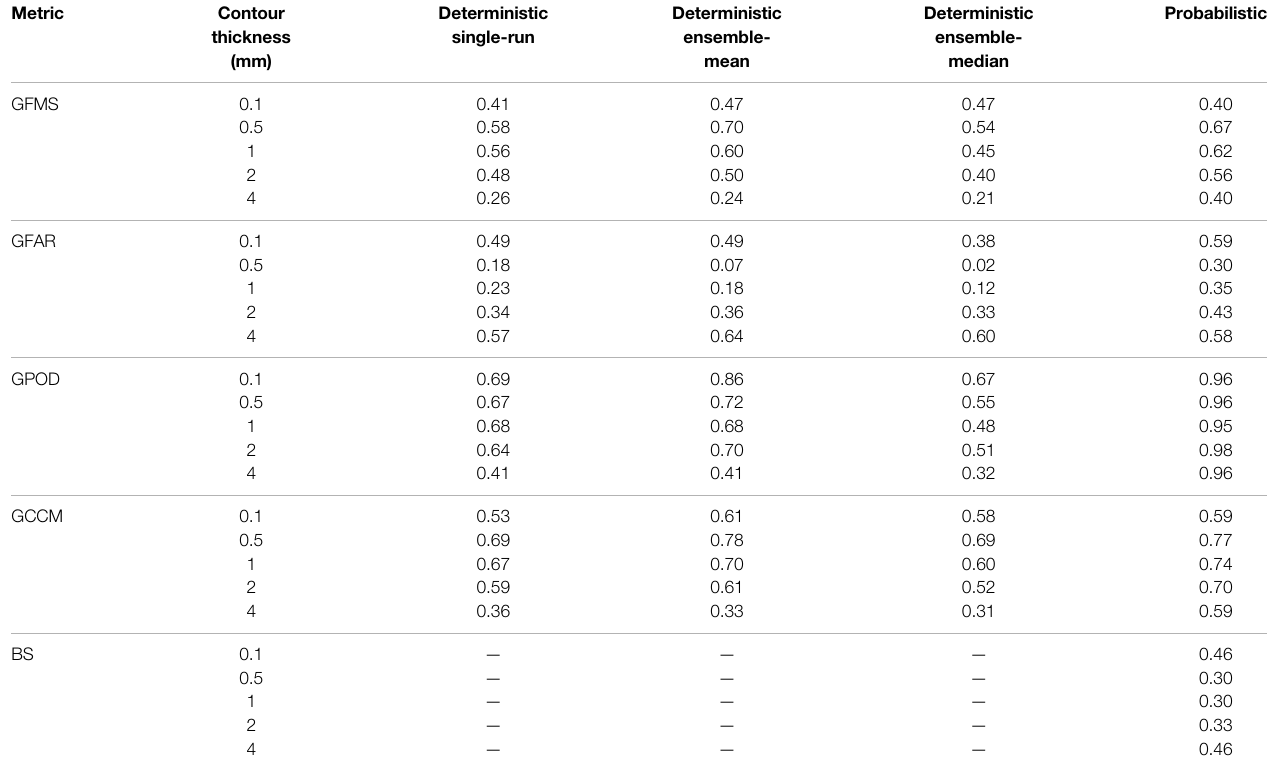
TABLE 7 | Validation of the April 22, 2015 Calbuco simulations with deposit isopach contours from Romero et al (2016). Five deposit isopach values of 0.1, 0.5, 1, 2, and 4 mm are considered. Best values for each metric and contour are highlighted in green. The Brier Score (BS) applies only to the probabilistic approach. Metric Contour